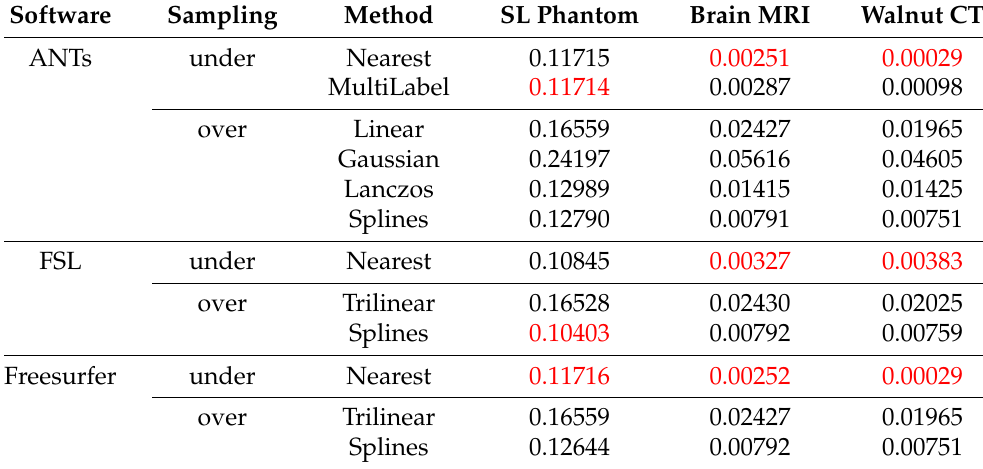
Table 2. Relative errors in two-norm of the mean value per VOI, computed with Equation (33). Minimal error per software per image in red. Empty cells indicate the same as